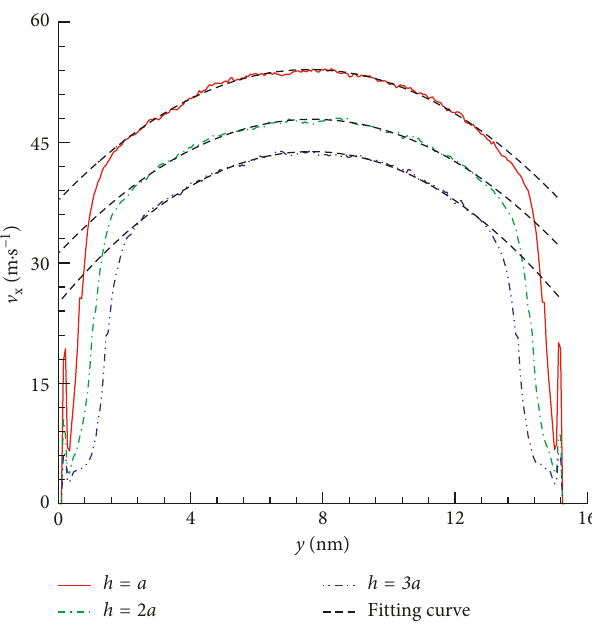
Figure 5: Velocity profiles at different roughness element heights.